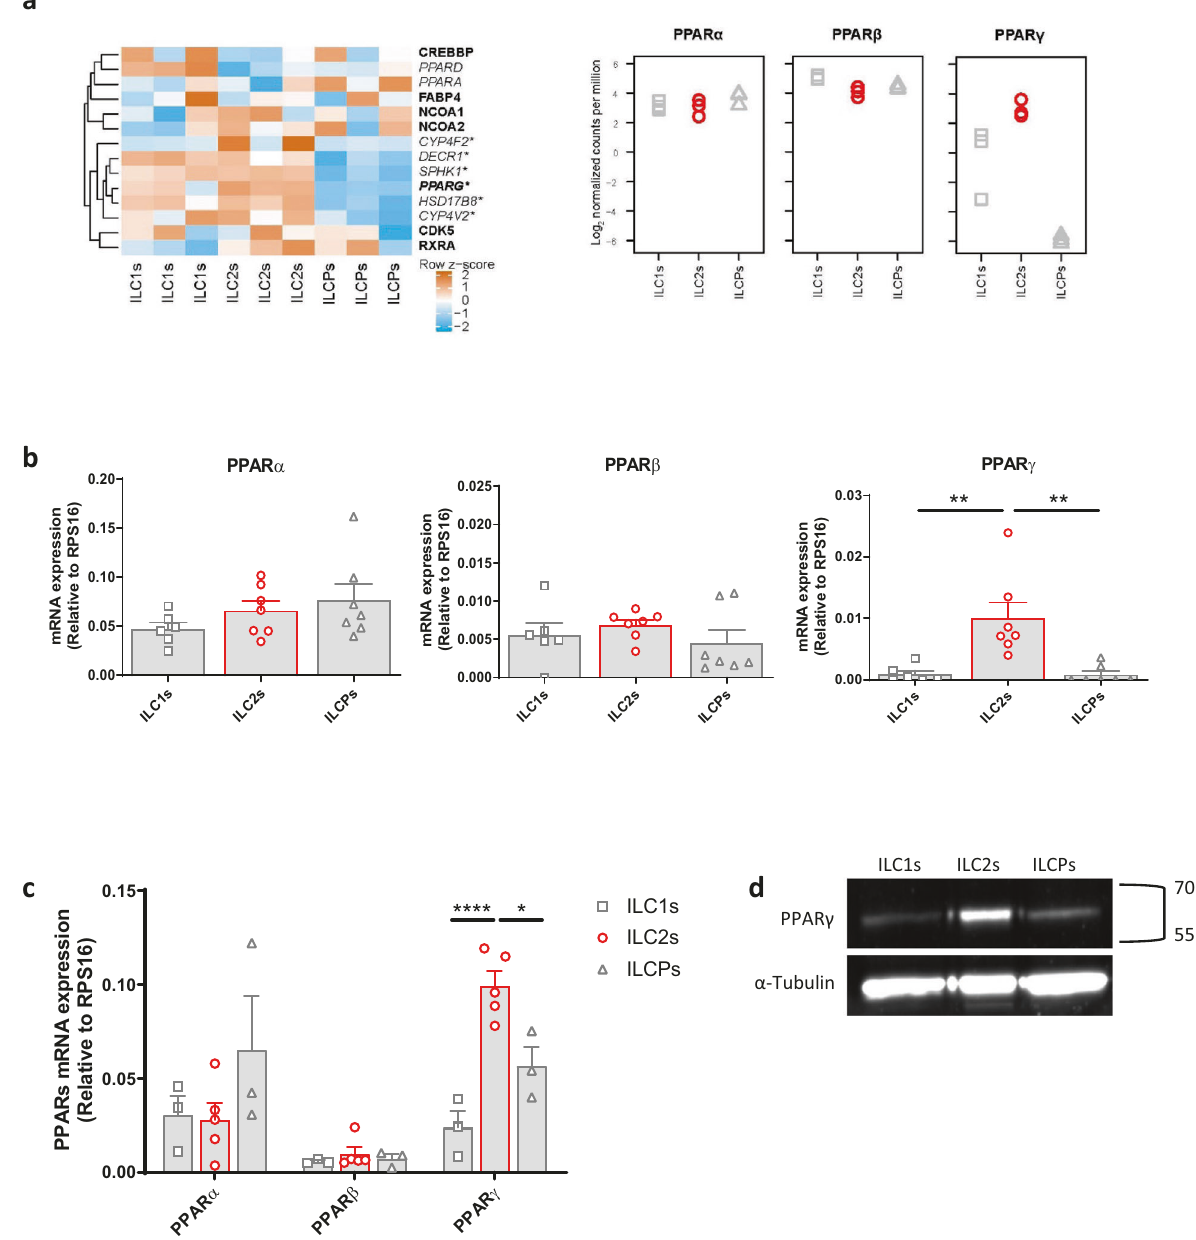
Fig. 1 Human ex vivo and in vitro expanded ILC2s speci fi cally express PPAR γ . a Heatmap of row z-scores of mRNA level of proteins involved in fatty acid metabolism (highlighted in italics) or involved in protein-protein interaction with PPAR γ (highlighted in bold). Fatty acid metabolism genes were taken from the “ fatty acid metabolic process ” Gene Ontology gene set (GO:0006631, http://geneontology.org/). RNA-sequencing counts were transformed to log2 counts per million, and differential gene expression analysis was performed by fi tting a linear model to each gene using the voom function in the limma package for R (v. 3.38.3), followed by a moderated t statistic computation using the empirical Bayes statistics model implemented in the limma package (See Ercolano et al. 1 for detailed methods). Genes signi fi cantly upregulated in ILC2s compared to ILC1s and/or ILCPs are indicated using an * ( n = 3; * P < 0.05). Proteins putatively involved in protein – protein interactions were taken from the STRING database (https://string-db.org/). b Expression of PPARs assessed by qPCR in human freshly sorted ILC subsets (open square ILC1s, open circle ILC2s, open triangle ILCPs) (ILC1s n = 6; ILC2s and ILCPs n = 7; ILC1s vs ILC2s ** P = 0.0032, ILC2s vs ILCPs ** P = 0.0021). c Expression of PPARs assessed by qPCR in in vitro expanded human ILC subsets (open square ILC1s, open circle ILC2s, open triangle ILCPs) (ILC1s and ILCPs n = 3; ILC2s n = 5; ILC1s vs ILC2s **** P < 0.0001, ILC2s vs ILCPs * P = 0.0020). d Western blot analysis of PPAR γ expression at protein level in ILC2s compared to ILC1s and ILCPs (one individual experiment). Each symbol represents one individual donor. Data are shown as mean ± SEM and were analyzed by one- ( b ) or two-way ( c ) ANOVA tests. Source data are provided as a Source data fi